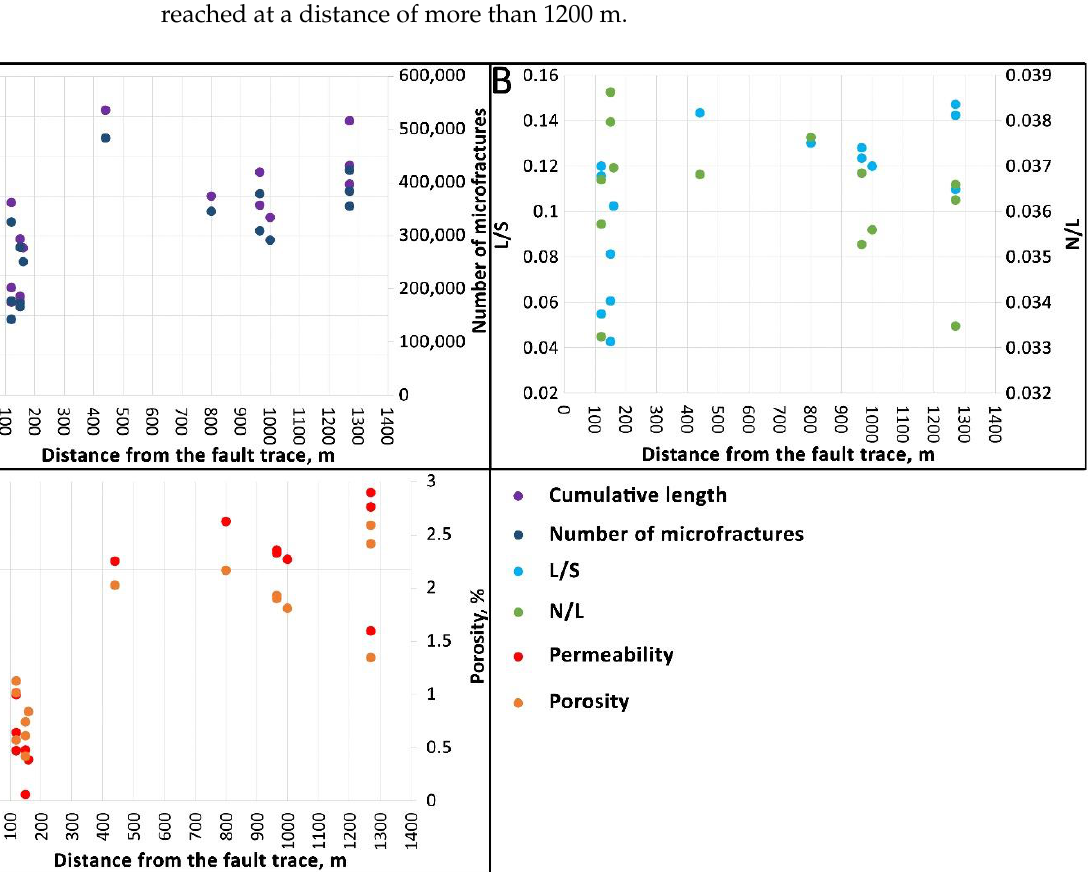
Figure 11. Graphs of the distribution of cumulative length versus number of microfractures ( A ), L/S versus N/L ( B ), permeability versus porosity ( C ) with distance from the fault trace.